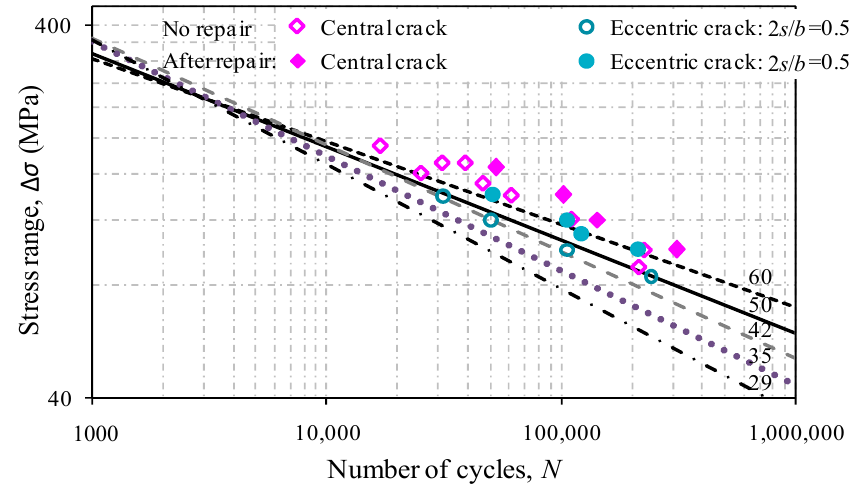
Figure 11. Comparison of fatigue live results between unrepaired and repaired plates.